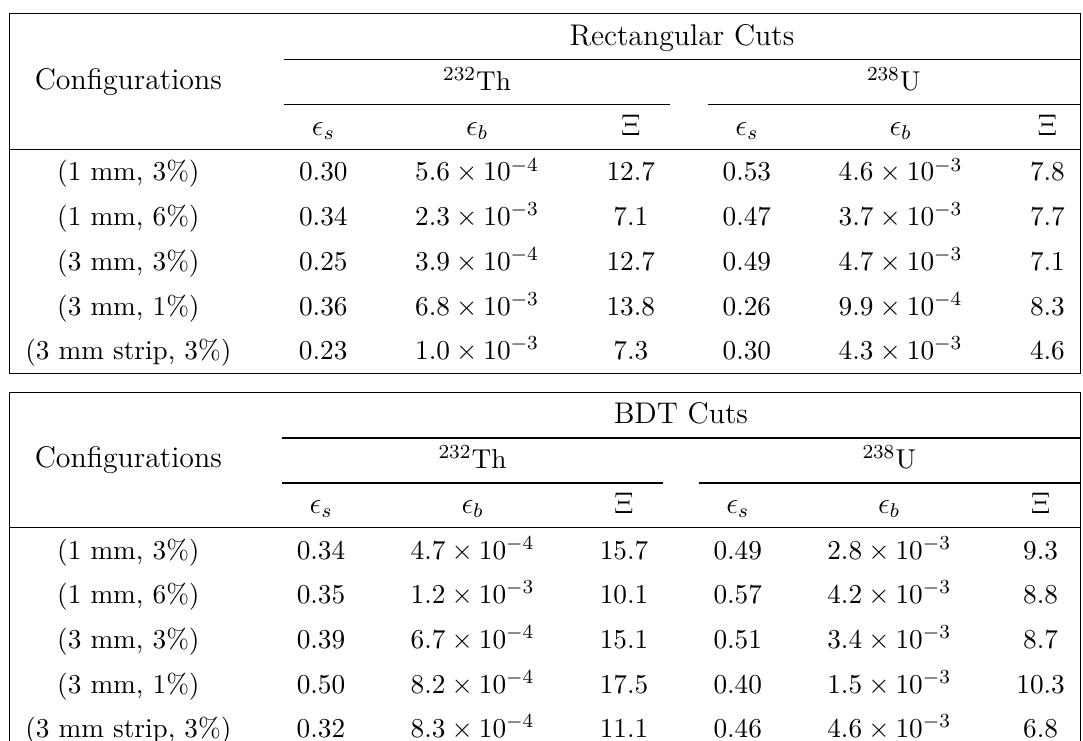
Table 1. Effects of rectangular cuts and BDT cuts on (cid:15) s , (cid:15) b , and Ξ in the five Configurations. Background events from 232 Th and 238 U are considered separately. We define the discrimination (cid:14) √ significance Ξ = (cid:15) s (cid:15) b , where (cid:15) s is the signal efficiency and (cid:15) b the background efficiency after the